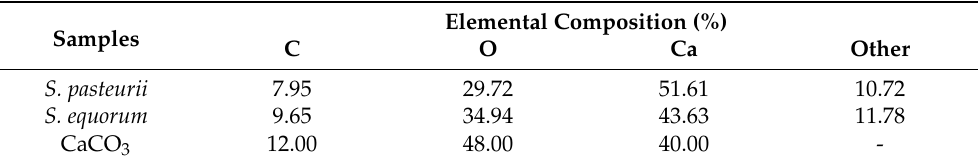
Table 2. Semi-quantitative elemental composition determined by SEM-EDX for precipitates obtained from calcite production assay and theorical composition of calcium carbonate.